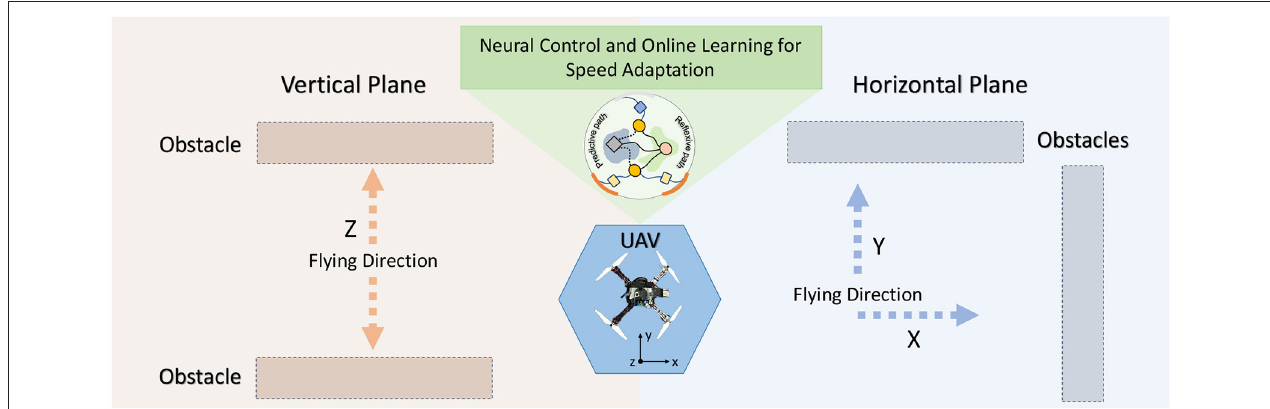
FIGURE 2 | Setup for testing and demonstrating the performance of the control system. In this scenario, a UAV flies at a given speed toward an obstacle. When it becomes close to the obstacle, the learning system allows it learn to gradually adapt its speed and brake at a safe distance from the obstacle. The proposed control and learning system is not restricted to a certain flying direction. It can be used to adapt the flying speed of a UAV in the horizontal and vertical planes (i.e., x, y, or z